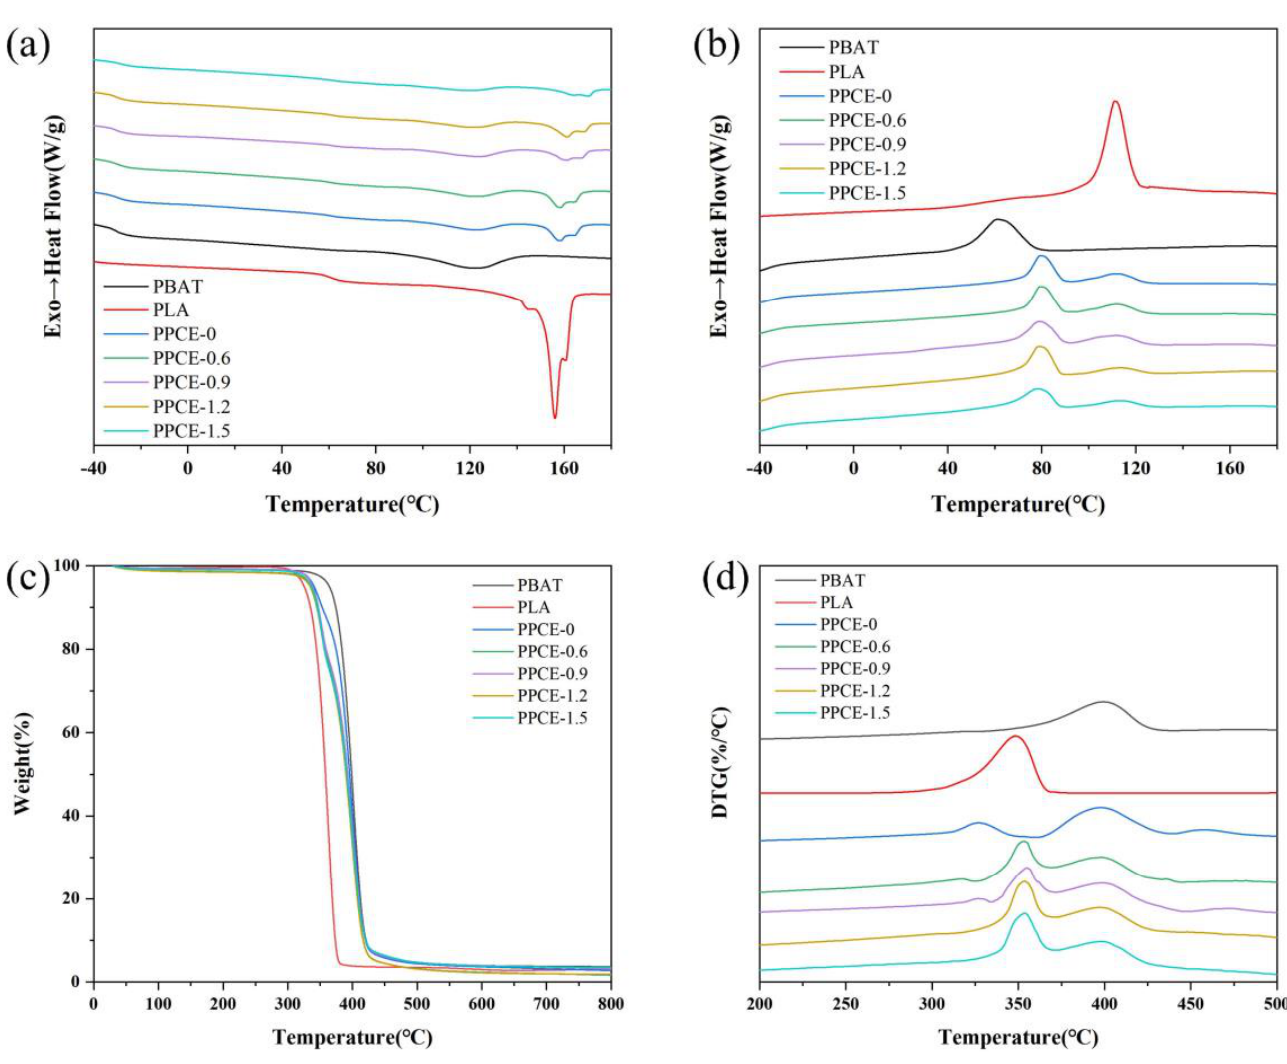
Figure 2. Characterization of different samples. DSC curves of different samples: ( a ) DSC heating curves, ( b ) DSC cooling curves. TGA curves of different samples: ( c ) TG curves, ( d ) DTG curves. The final crystallinity ( X c ) of both the PBAT and PLA phases decreased after their blending and further decreased after the addition of the CE. This is due to the higher